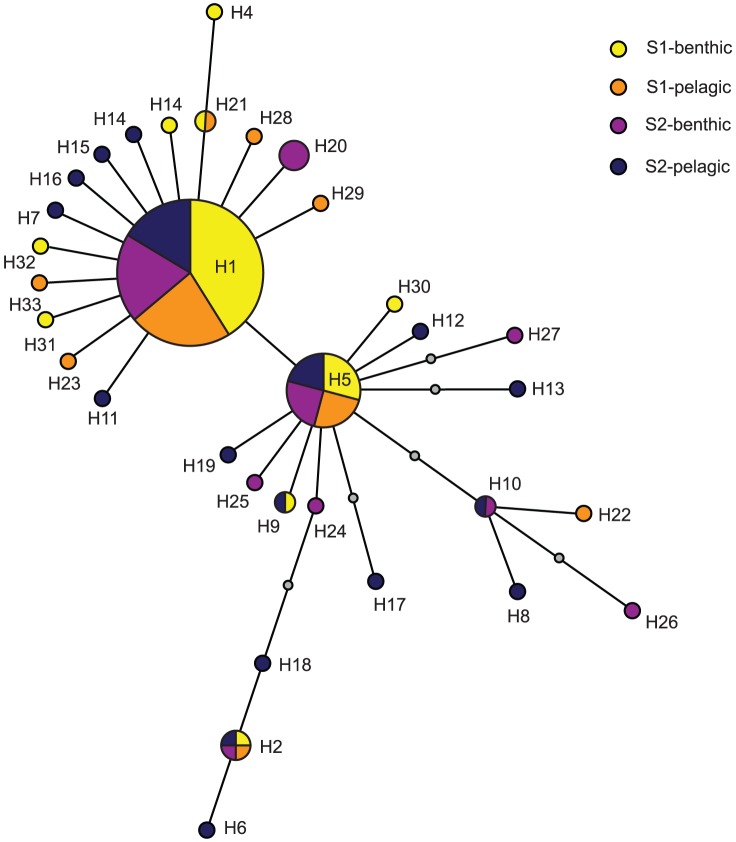
Minimum spanning tree depicting haplotypic relativeness.